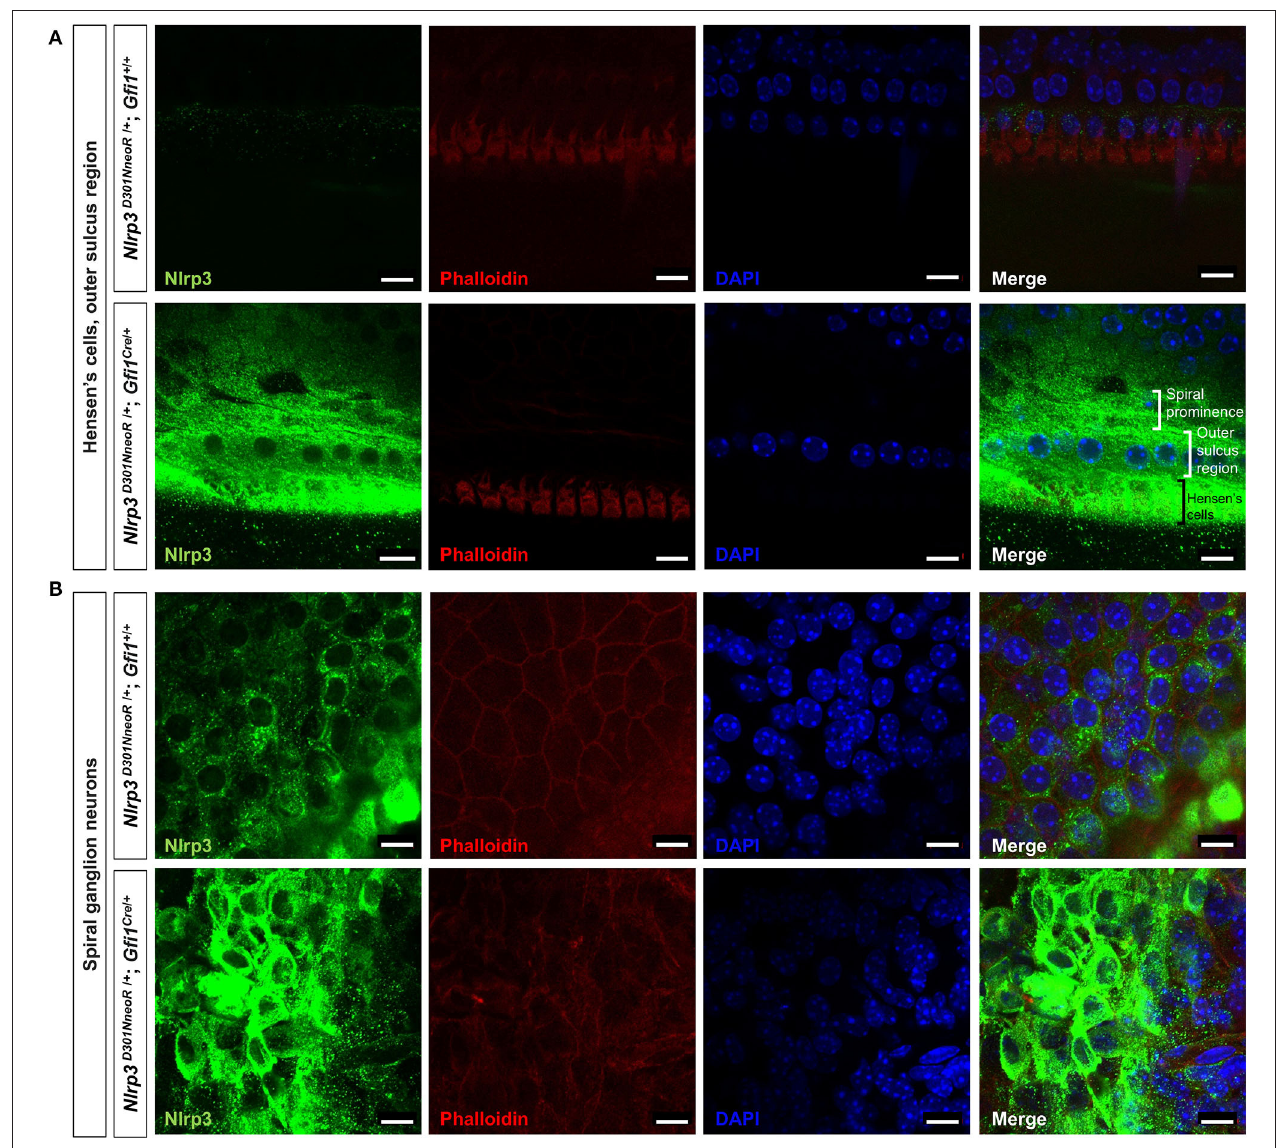
FIGURE 4 | Whole-mount immunofluorescence of a P15 Nlrp3 D 301 NneoR / + /+ ; Gfi1 Cre / + mouse cochlea and a Nlrp3 D 301 NneoR / + ; Gfi1 + / + mouse cochlea. Nlrp3 was overexpressed in the Nlrp3 D 301 NneoR / + ; Gfi1 Cre / + mouse [bottom panels of (A,B) ] compared to the Nlrp3 D 301 NneoR / + ; Gfi1 + / + mouse [top panels of (A,B) ] in Hensen’s cells and the outer sulcus region (A) and the spiral ganglion neurons (B) . ( n = 6 cochleae for Nlrp3 D 301 NneoR / + ; Gfi1 Cre / + and n = 6 cochleae for Nlrp3 D 301 NneoR / + ; Gfi1 + / + ) Nlrp3 in green, phalloidin in red, DAPI in blue, the scale bars represent 10 µ m. P15, postnatal day